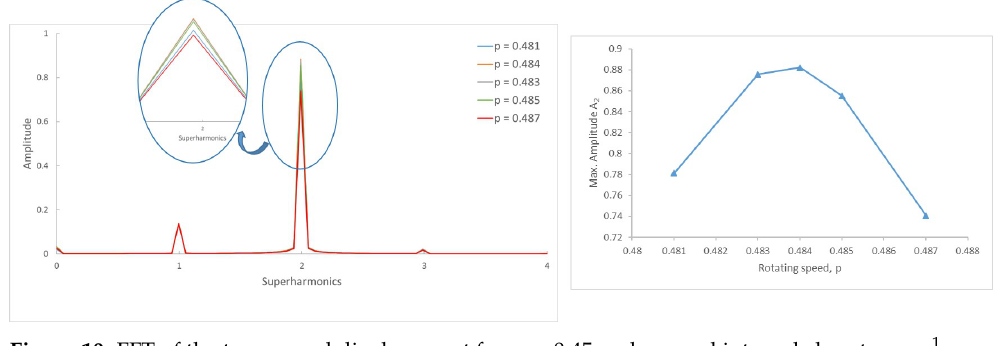
Figure 10. FFT of the transversal displacement for α = 0.45 and a speed interval close to p = 1